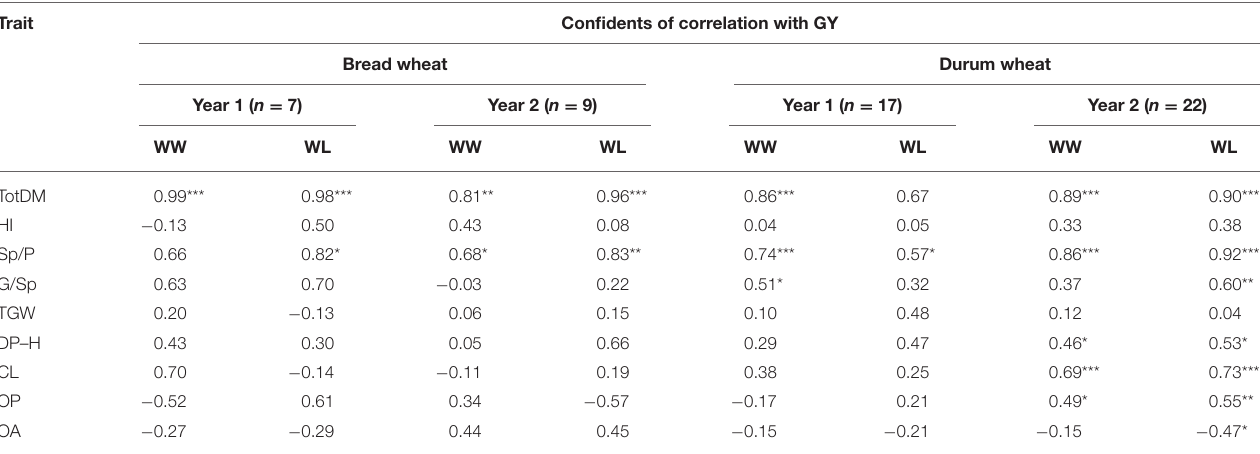
TABLE 4 | Correlation of various traits with grain yield (GY) under the different treatments and years. Trait Confidents of correlation with GY Bread wheat Durum